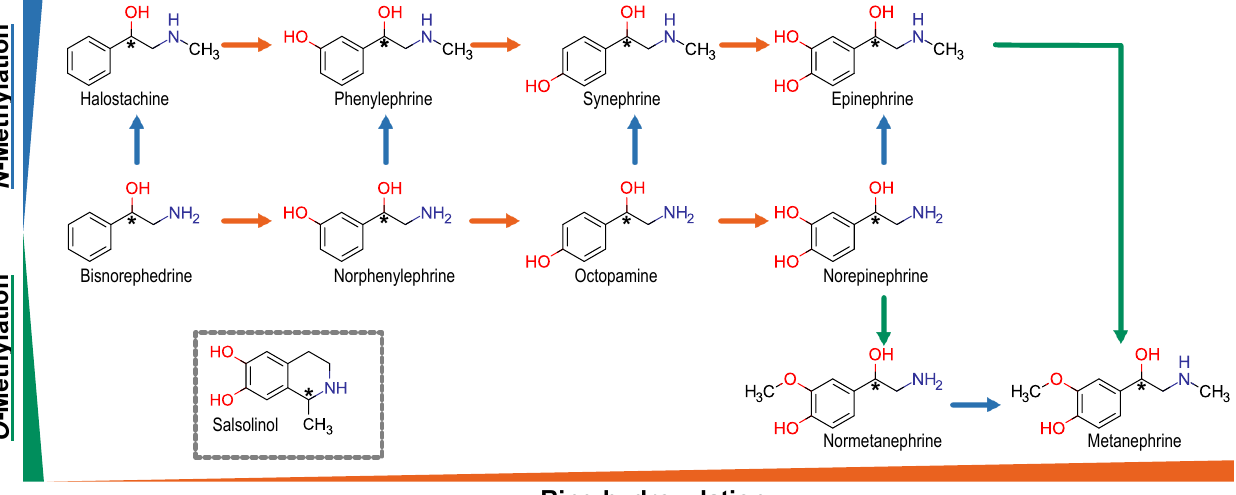
Figure 1. Chemical relationship of investigated substances. Apart from salsolinol, all substances were beta-hydroxylated phenylethylamines. All substances differed only by single structural alterations, including hydroxylation of the phenolic ring, methylation of the primary amino group and methyla- tion of the para-hydroxy group. Salsolinol is characterized by a second ring which may be formed by condensation of dopamine with acetaldehyde. Chiral centers are marked with an asterix (*). All phenylethylamines have a single amino group positively charged at physiological pH [11]; thus, passive nonionic diffusion over cellular membranes is limited. Several transporter proteins facilitate the uptake of phenylethylamines. Predominantly, high- affinity monoamine transporters (MATs) of the SLC6 gene family control synaptic levels of monoamine neurotransmitters mostly by presynaptic reuptake of released neurotransmit- ters [12]. The norepinephrine (NET/ SLC6A2 ), dopamine (DAT/ SLC6A3 ), and serotonin transporters (SERT/ SLC6A4 ) are characterized by a high affinity towards their